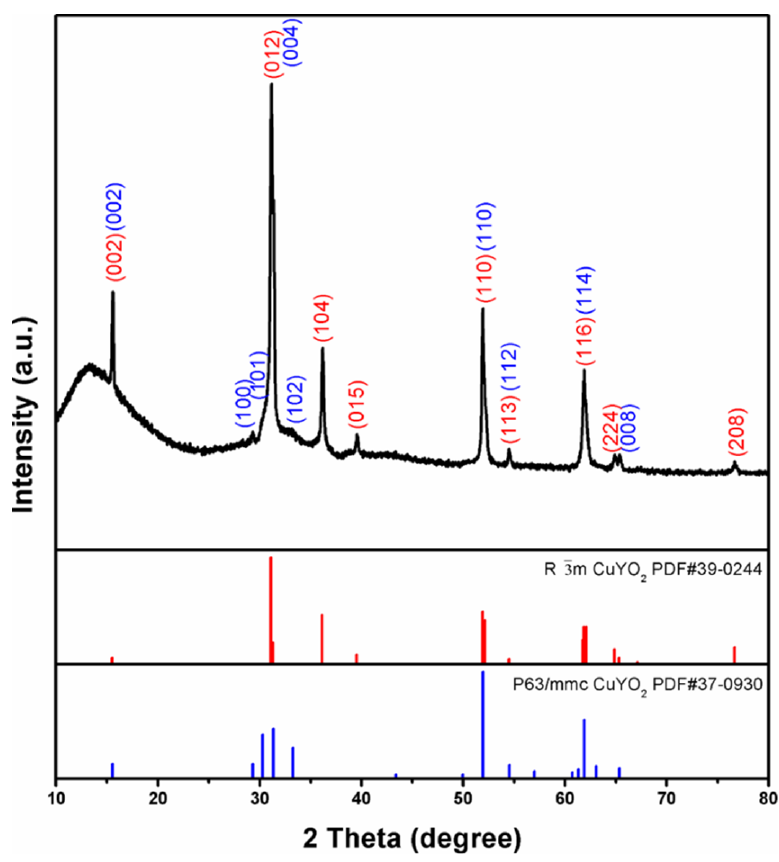
Figure 3. XRD pattern CuYO 2 nanofibers.